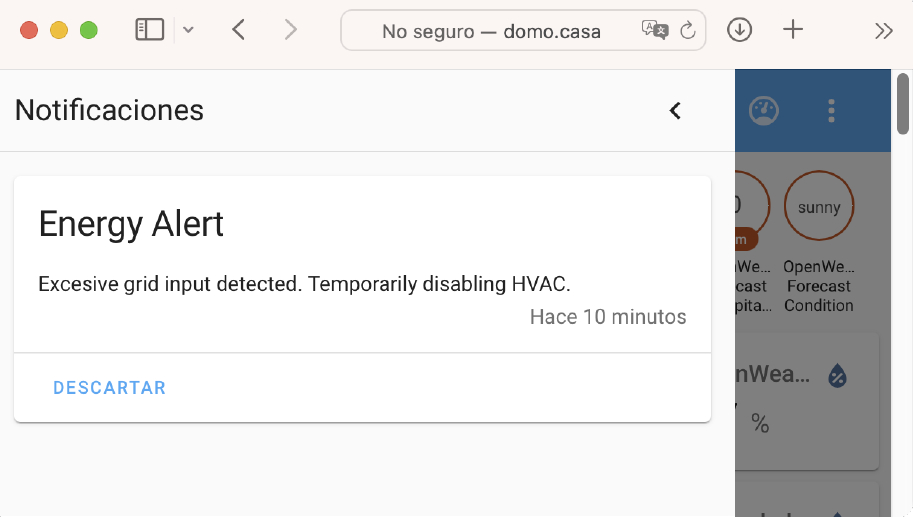
Figure 17. Alerting and notification through Home